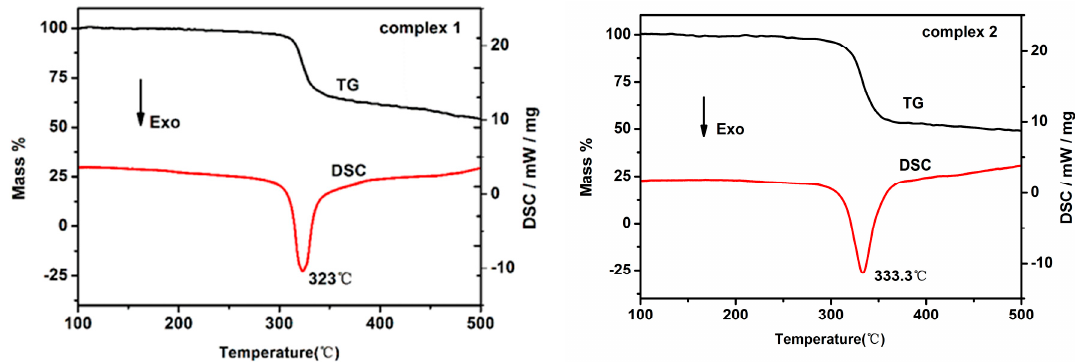
Figure 4. TG/DSC curves of complexes 1 and 2.